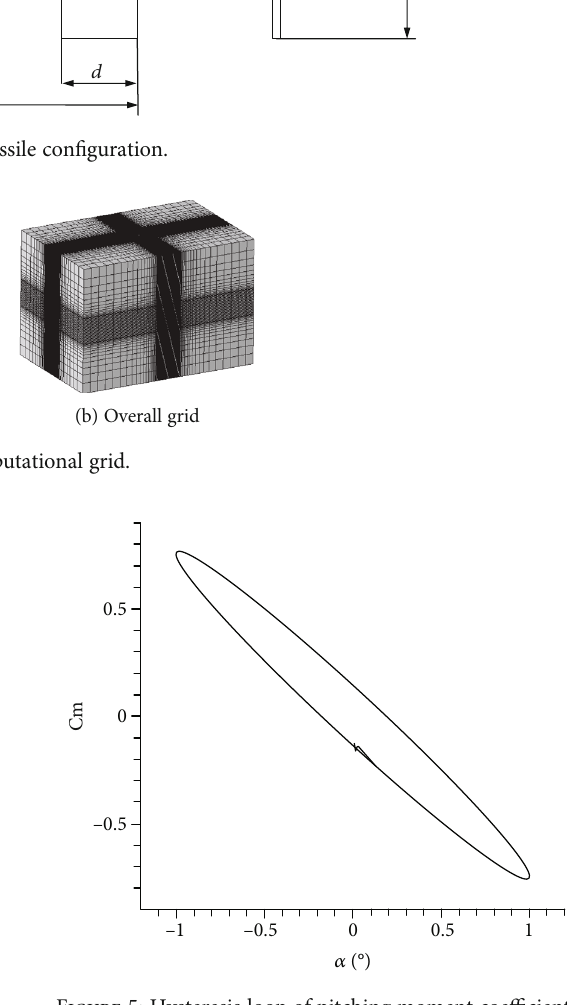
Figure 5: Hysteresis loop of pitching moment coe ffi cient.